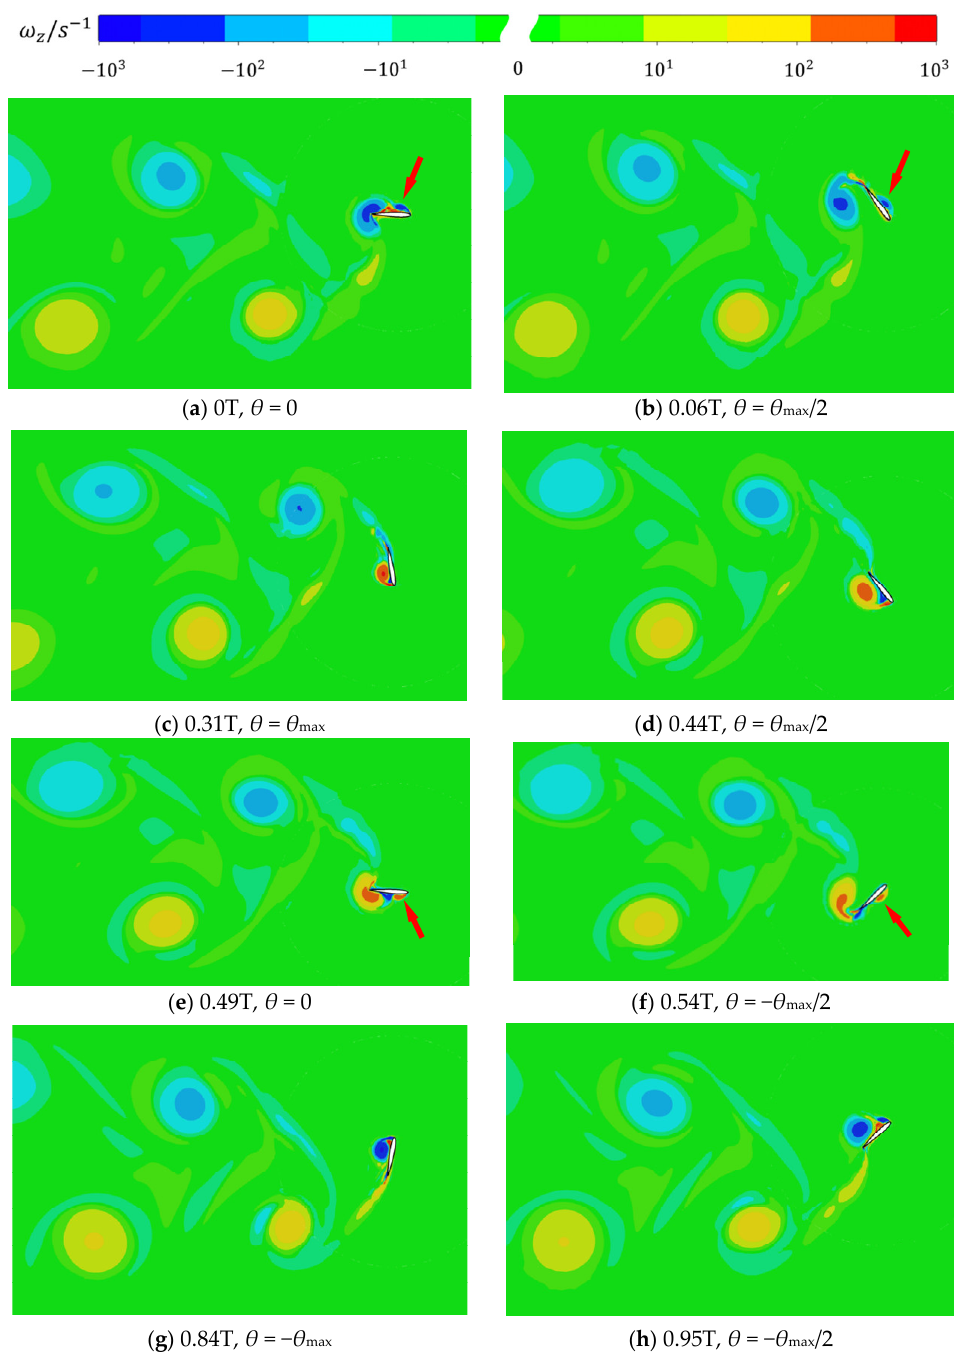
Figure 10. Time evolution of wake vortex diagrams being formed during one cycle with damping coefficient ζ = 0.177 in baseline case: ( a ) 0T, θ = 0; ( b ) 0.06T, θ = θ max /2; ( c ) 0.31T, θ = θ max ; ( d ) 0.44T, θ = θ max /2; ( e ) 0.49T, θ = 0; ( f ) 0.54T, θ = − θ max /2; ( g ) 0.84T, θ = − θ max ; ( h ) 0.95T, θ = − θ max /2.